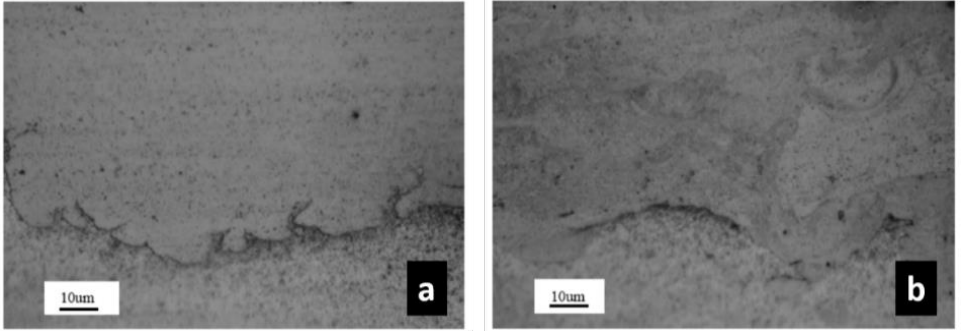
Figure 3. Cross-sectional views of the conventional powder ( a ) and the nanoscale powder ( b ) cold-sprayed deposits.